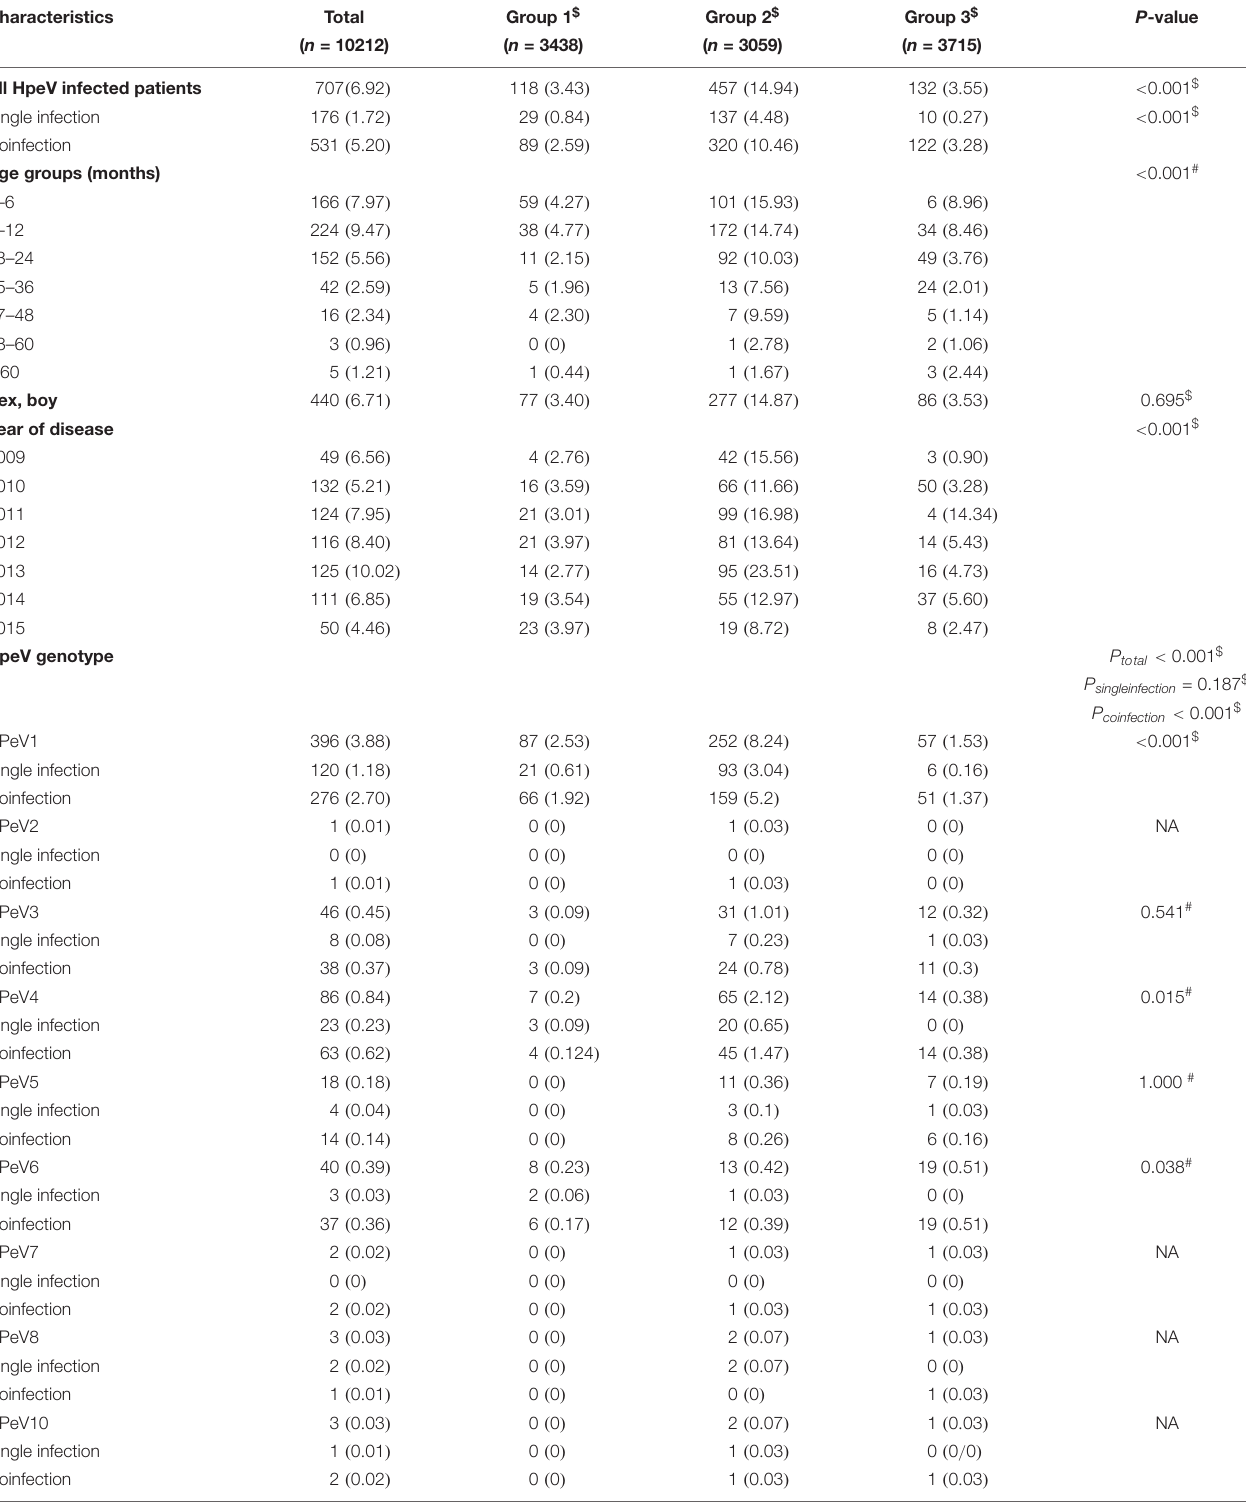
TABLE 1 | The detection and genotyping of HPeVs in three cohorts of pediatric patients.